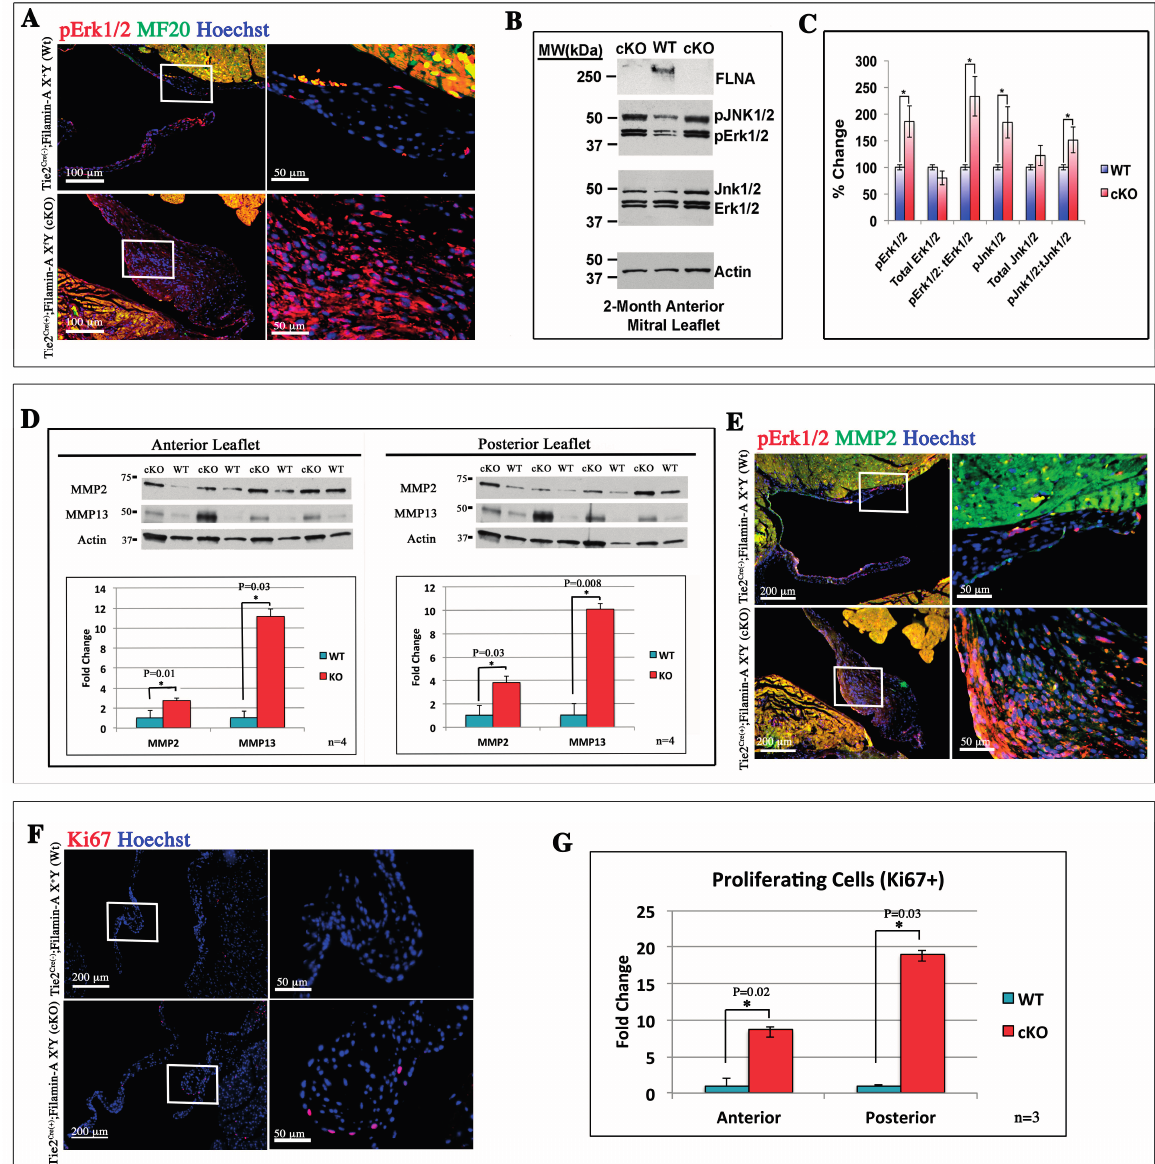
Figure 2. Erk1/2 Signaling, MMP expression, and Cell Proliferation are Increased in the Filamin-A cKO ( A ) IHC for phospho-Erk1/2 ( red ), MF20 ( green ), and nuclei ( blue ) demonstrate increased pErk accumulation in the 2-month-old cKO mitral valve; ( B ) Isolated anterior mitral leaflets from 2-month-old animals were analyzed individually by Western blot and demonstrate increased pErk1/2 and pJNK in relation to total protein, in the cKO compared to the WT; ( C ) Quantification of Western blot with * p < 0.05, n > 4; ( D ) Isolated anterior and posterior leaflets of cKO animals show increased expression of MMP2 and MMP13 compared to WT animals. All significant values are * p < 0.05, n = 4; ( E ) Immunofluorescence shows co-localization of pErk1/2 ( red ) with MMP2 expression (green); ( F ) Proliferating cells marked by Ki67 ( red ) and nuclei ( blue ) were quantified; ( G ) in both anterior and posterior leaflets. All significant values are * p < 0.05, n =